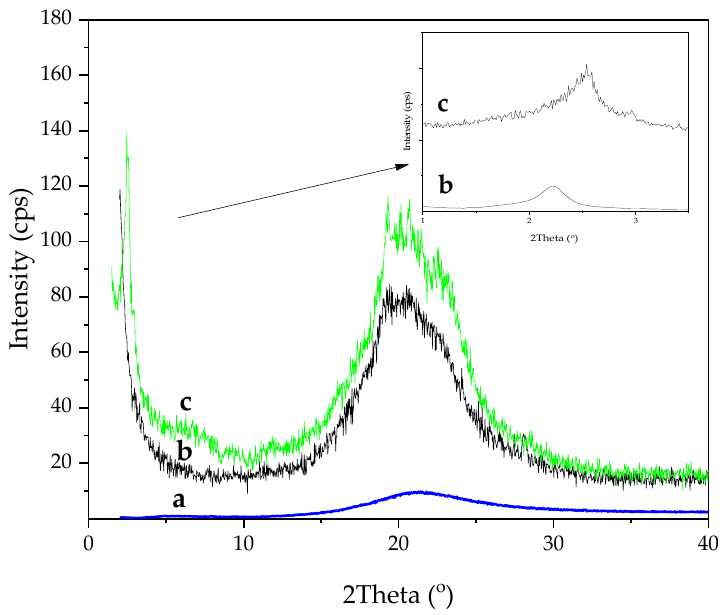
Figure 2. WAXD at room temperature of: CP0 ( a ), CP40 ( b ) and CP20 ( c ). Inset: SAXD of CP40 ( b ) and CP20 ( c ).